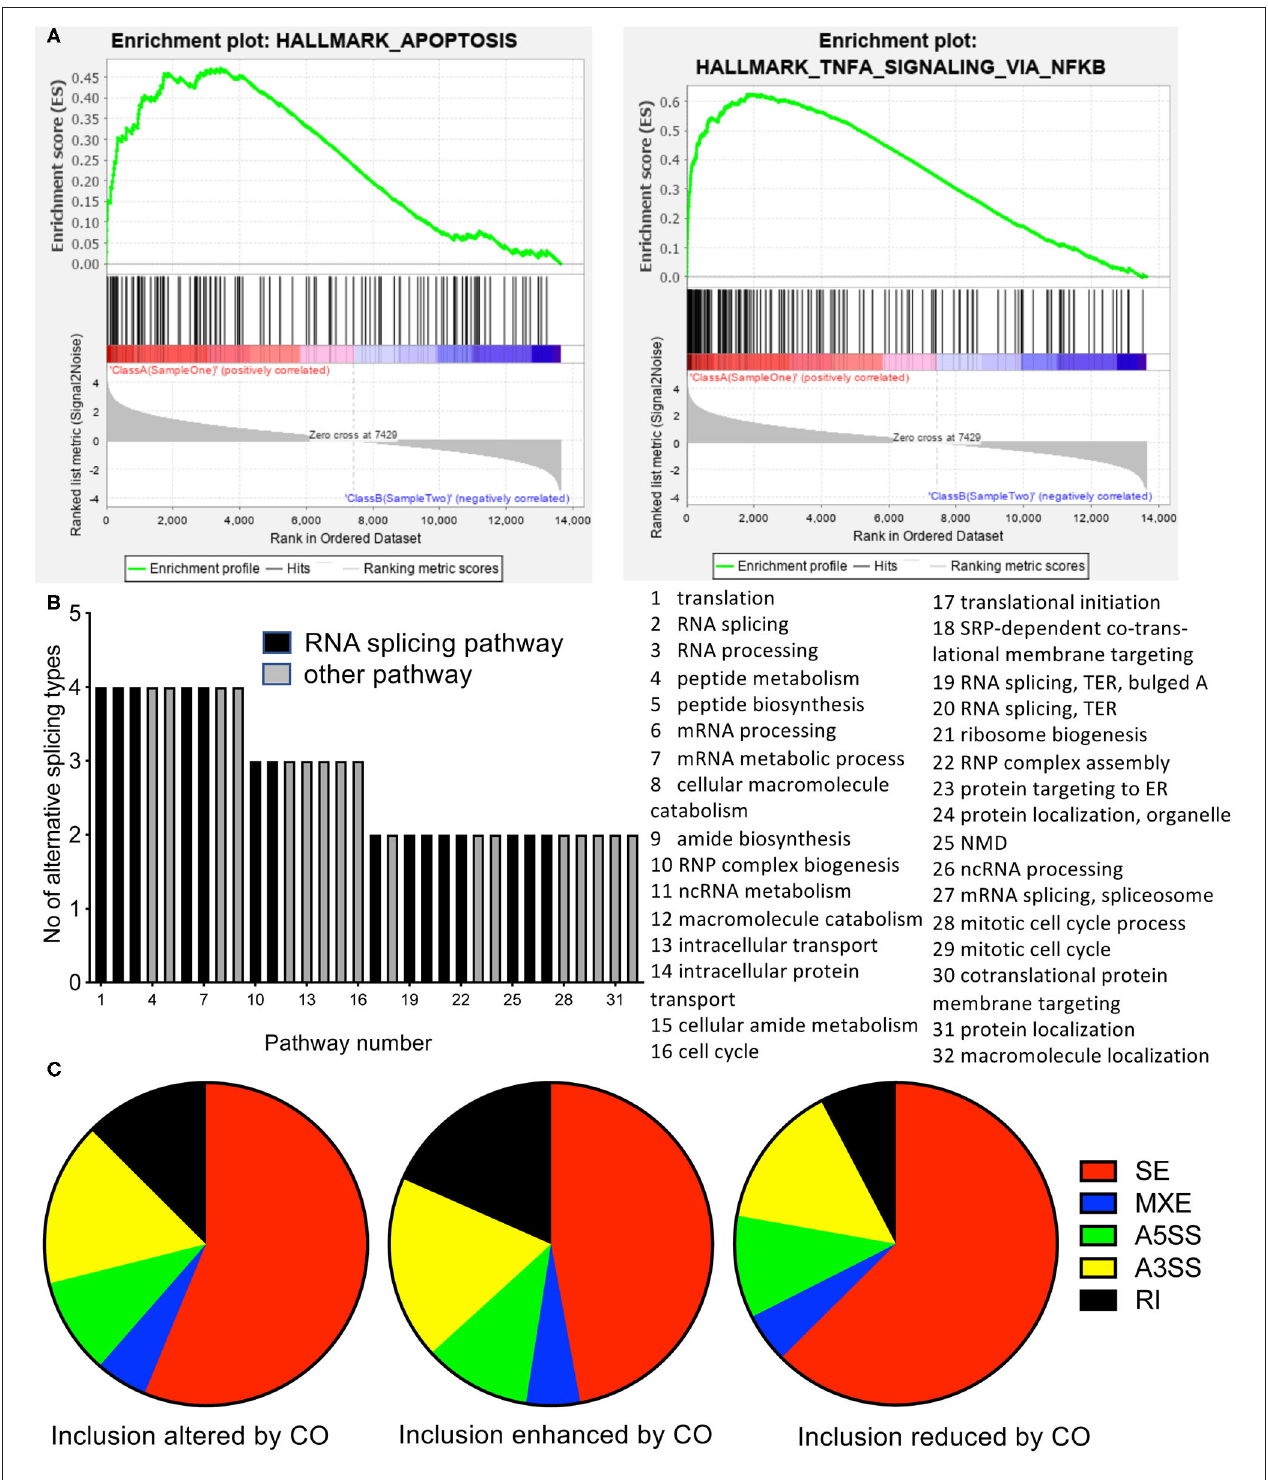
FIGURE 2 | RNASeq analysis of cells treated with C. orbiculata extract. (A) Gene set enrichment analysis (GSEA) of RNA up or down regulated by treatment. Apoptotic and cell cycle genes were significantly altered. (B) Gene ontology analysis on altered splicing genes by gene set pathway analysis. Of the 15 pathways with the most significant change in percent spliced in (PSI) of the gene isoforms for each splice type the number of splice types are shown (i.e., 5 = the pathway was in the top 15 for all five splice types, 1 = the pathway was in the top 15 for only one splice type. (C) Distribution of gene splicing between the five types for isoforms altered either way, event included, or event excluded. SE, Skipped exon; MXE, mutually exclusive exons; A5SS, Alternative 5 ′ splice site; A3SS, alternative 3 ′ splice site; RI, retained intron.